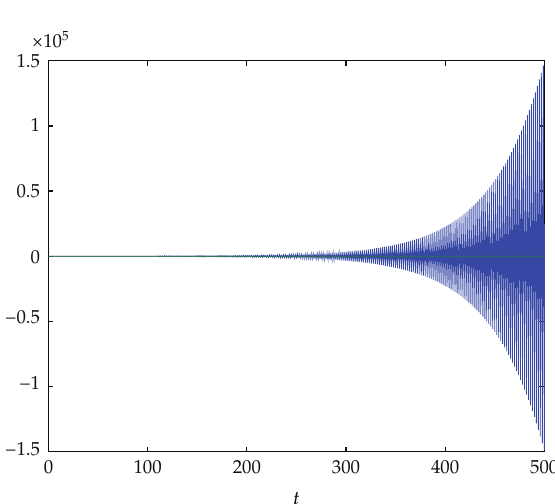
Figure 1: The numerical solution obtained by (cid:6) 3.11 (cid:7) in case of the 2-step BDF method to (cid:6) 4.6 (cid:7)